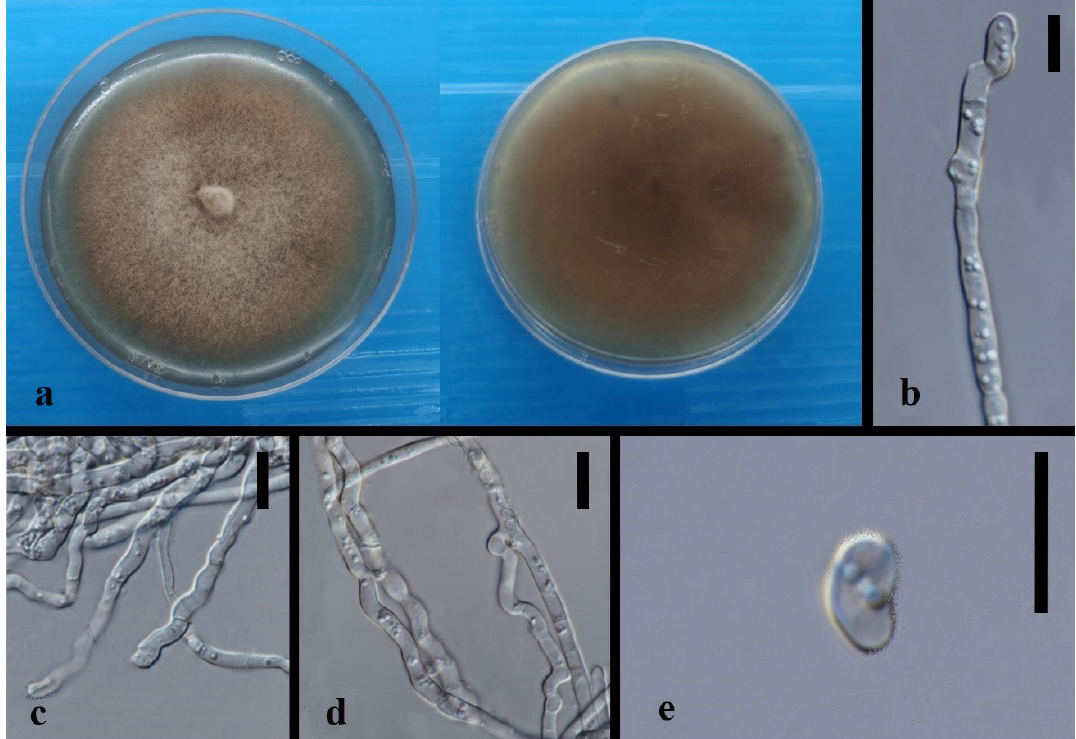
Figure 15. Xylaria sp.2. ( a ) Colony on 2% MEA (MFLUCC 21-0014) (left-front view, right-reverse view). ( b ) Conidiophore with conidium. ( c , d ) Mycelia. ( e ) Conidium. Scale bars: ( b – e ) = 5 µ m. Notes: ( b – e ) on 4% OA.